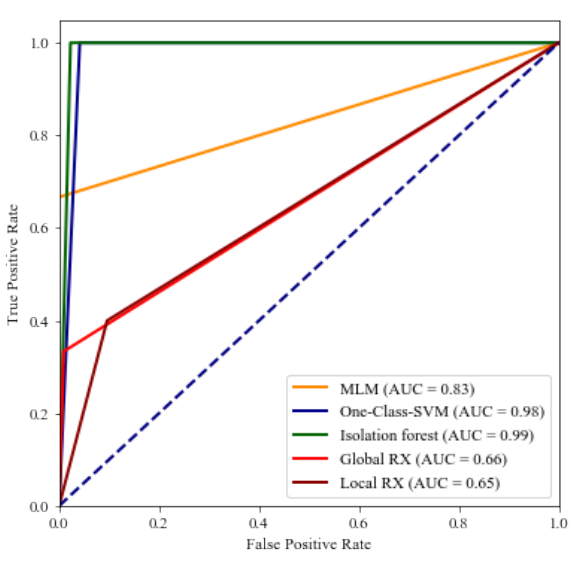
Figure 13. Comparison of the ROC-curves of the MLM and reference methods. ROC curve of the MLM shows that it does not have any false positives. MLM cannot find local anomalies.